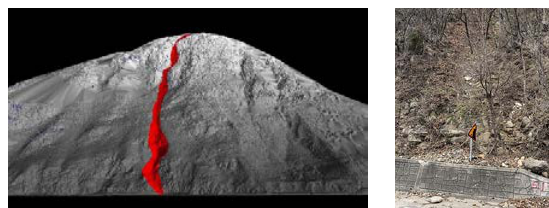
Figure 8. Jeongseon-gun steep old valley confirmed by